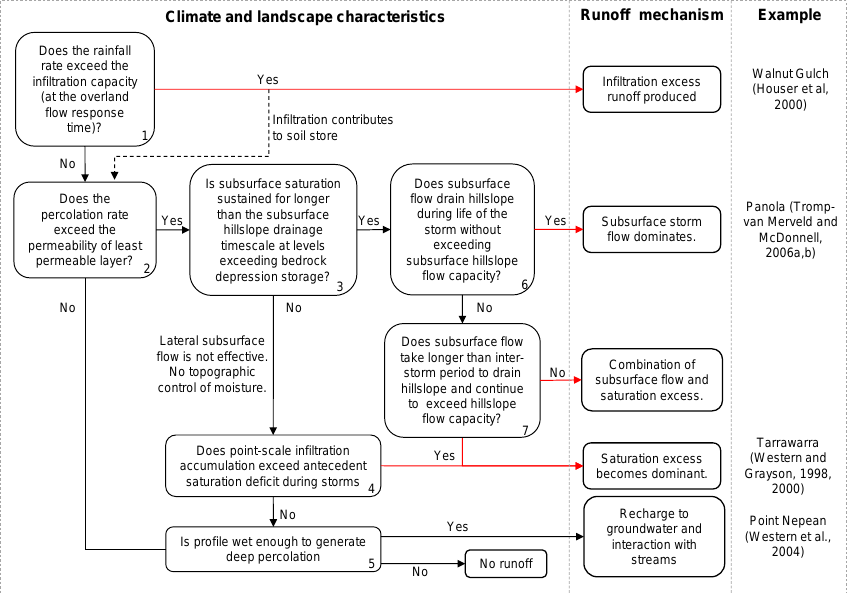
Figure 1. The role of flux and timescale thresholds in determining runoff processes. The red lines indicate cases where there is surface or subsurface hillslope connectivity to the